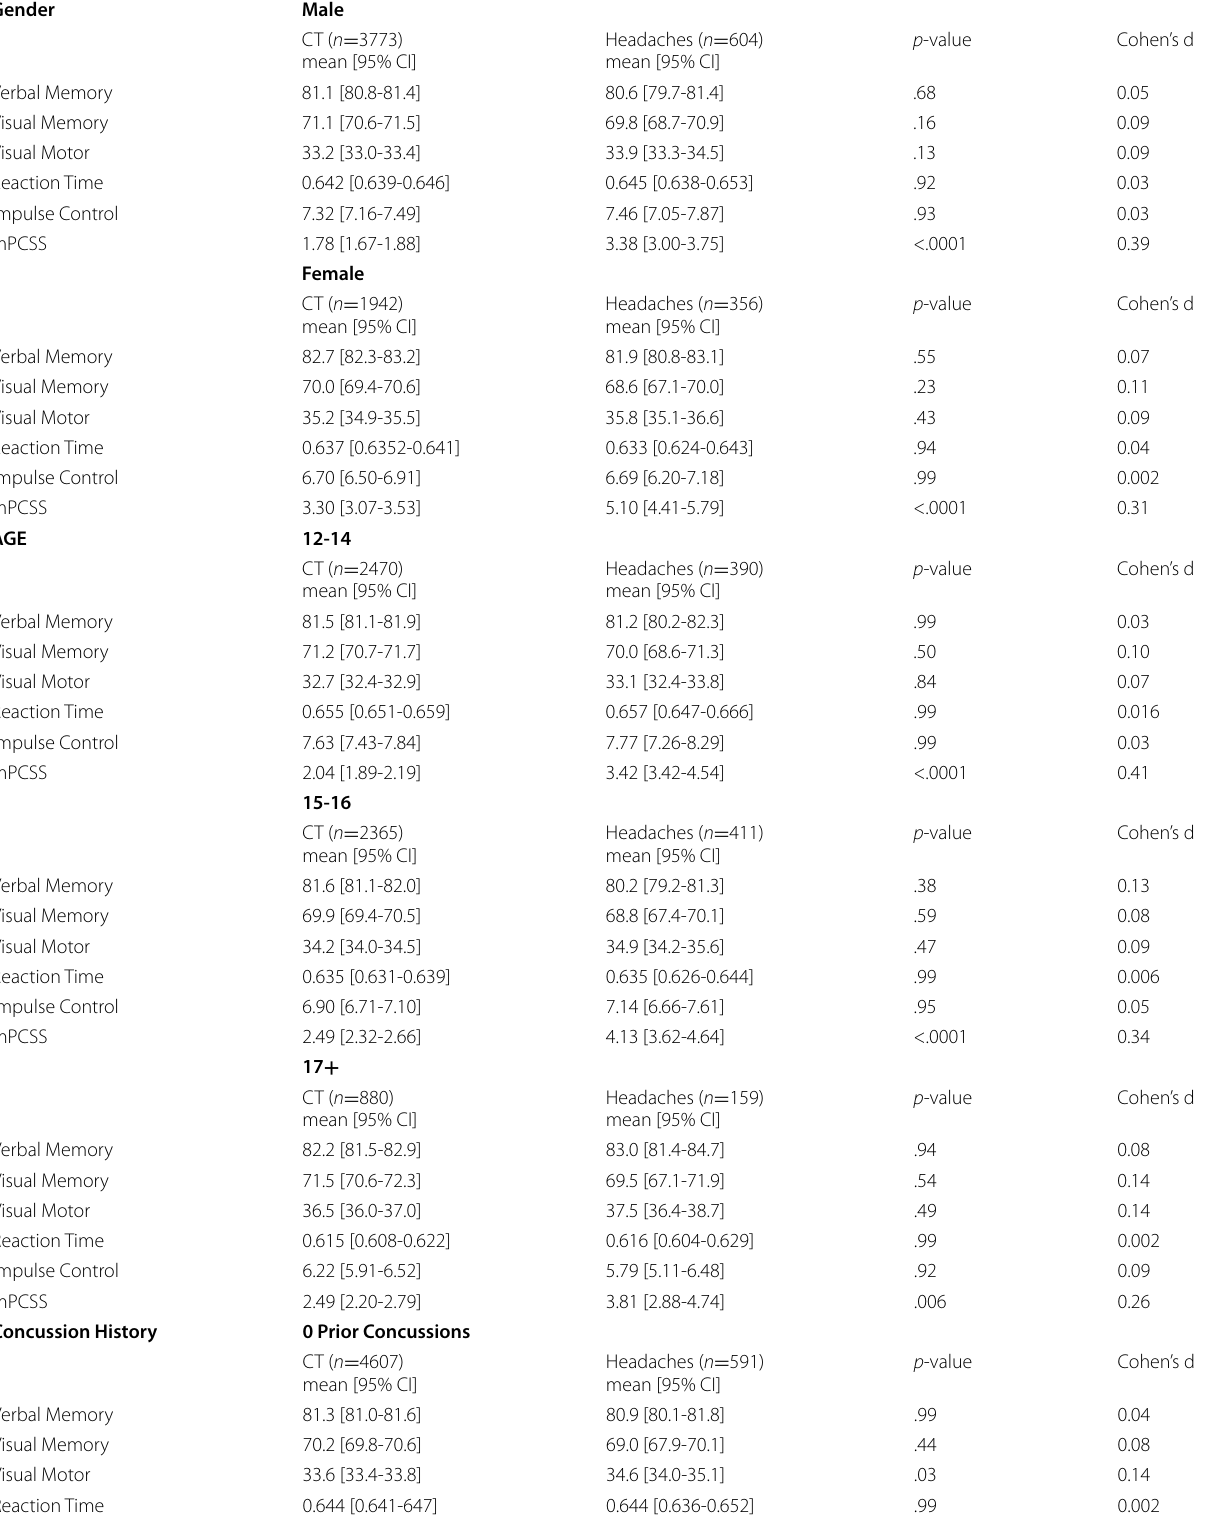
Table 3 Effect of HA Treatment on ImPACT Composite Scores by Gender, Age, and Concussion History